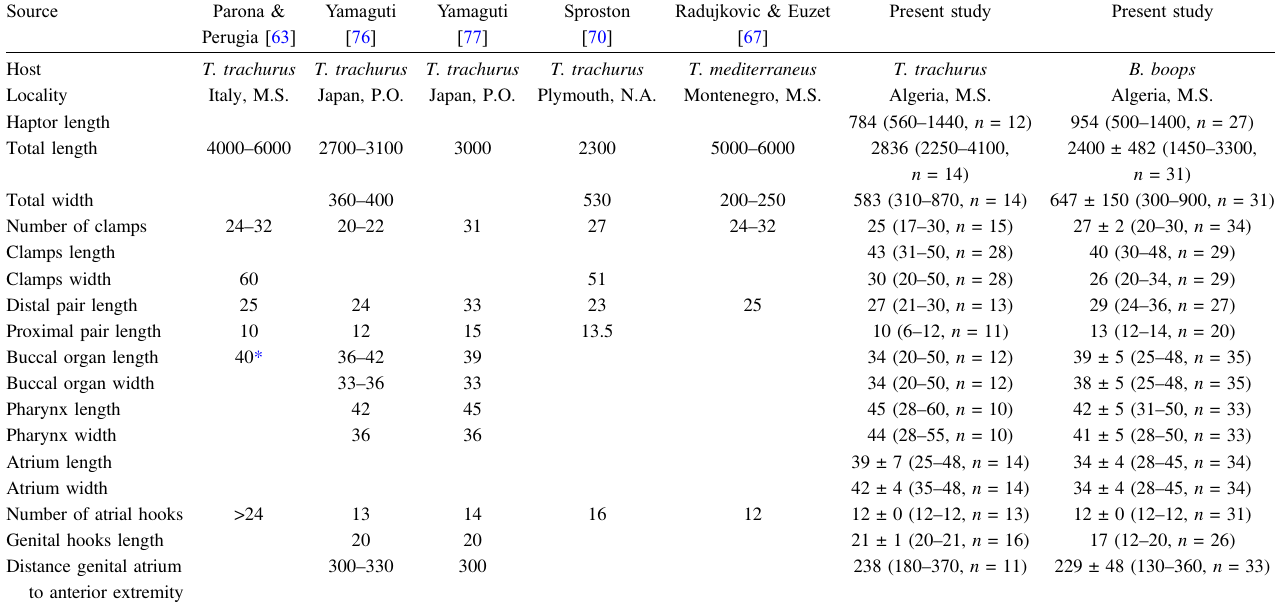
Table 2. Measurements of Pseudaxine trachuri from different hosts and